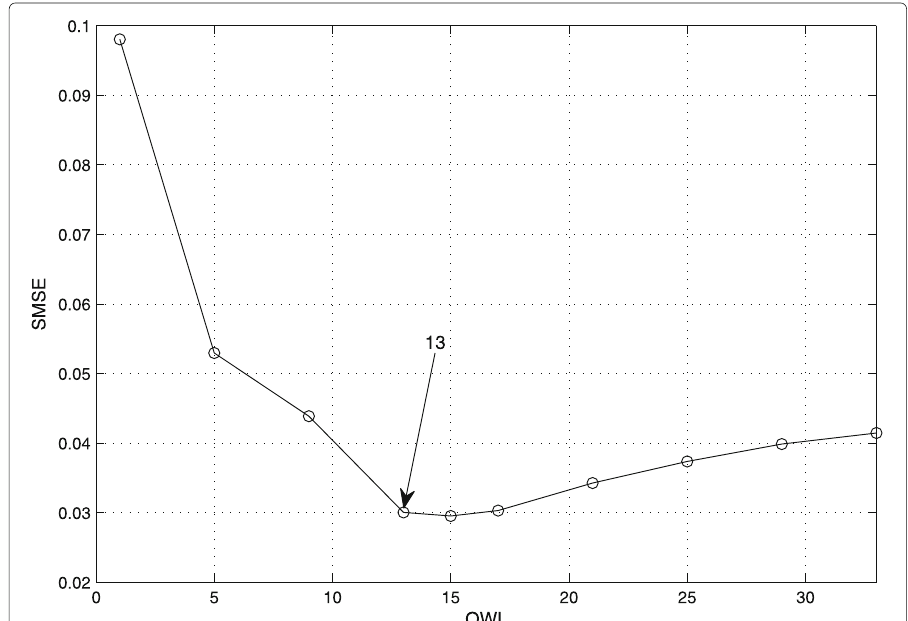
Fig. 2 SMSE performance for IOWL-BED with different OWL at SNR = 15